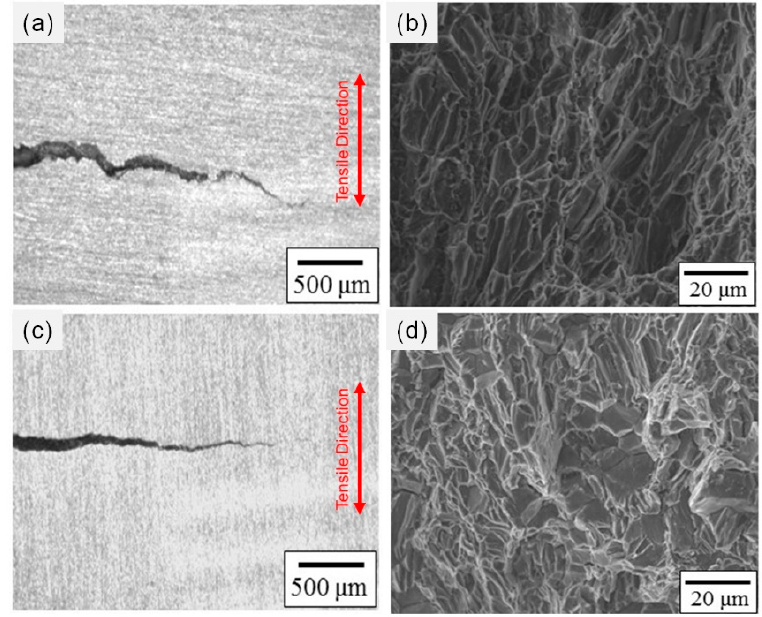
Figure 10. Crack morphology of XK105-H after fracture toughness test. ( a ) LM image on ED plane, ( b ) SEM image on ED plane, ( c ) LM image on TD plane, and ( d ) SEM image on TD plane.